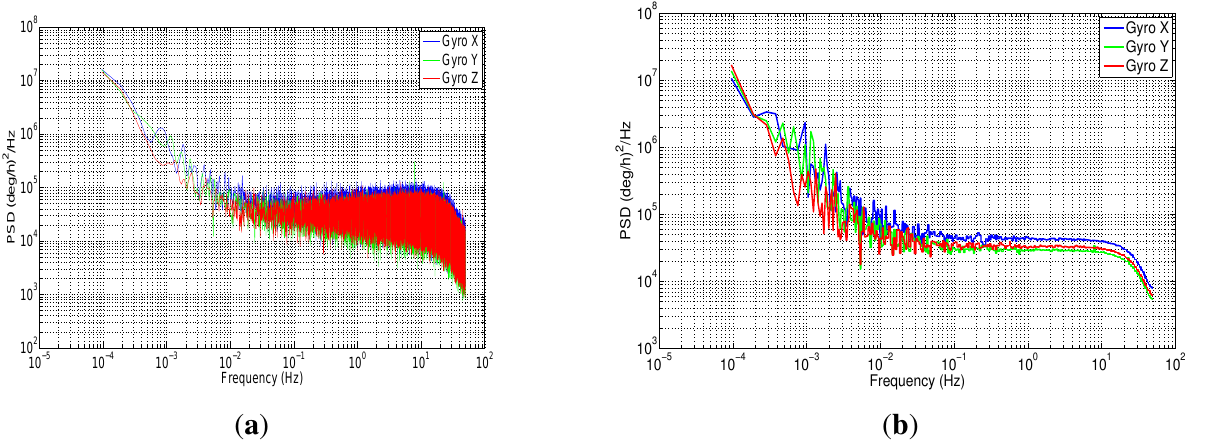
Figure 14. ( a ) Power spectral density gyro IMU 3DM-GX3-25; ( b ) power spectral density gyro IMU 3DM-GX3-25 after applying frequency